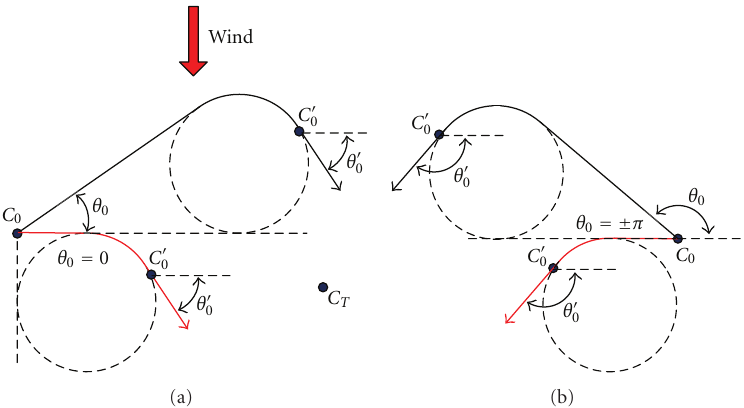
Figure 16: Initial configuration transformation when θ 0 ∈ [0, π ] and y T < y 0 . (a) θ 0 ∈ [0, π/ 2), red line indicates that θ 0 = 0 and (b) θ 0 ∈ ( π/ 2, π ], red line indicates that θ 0 = ± π